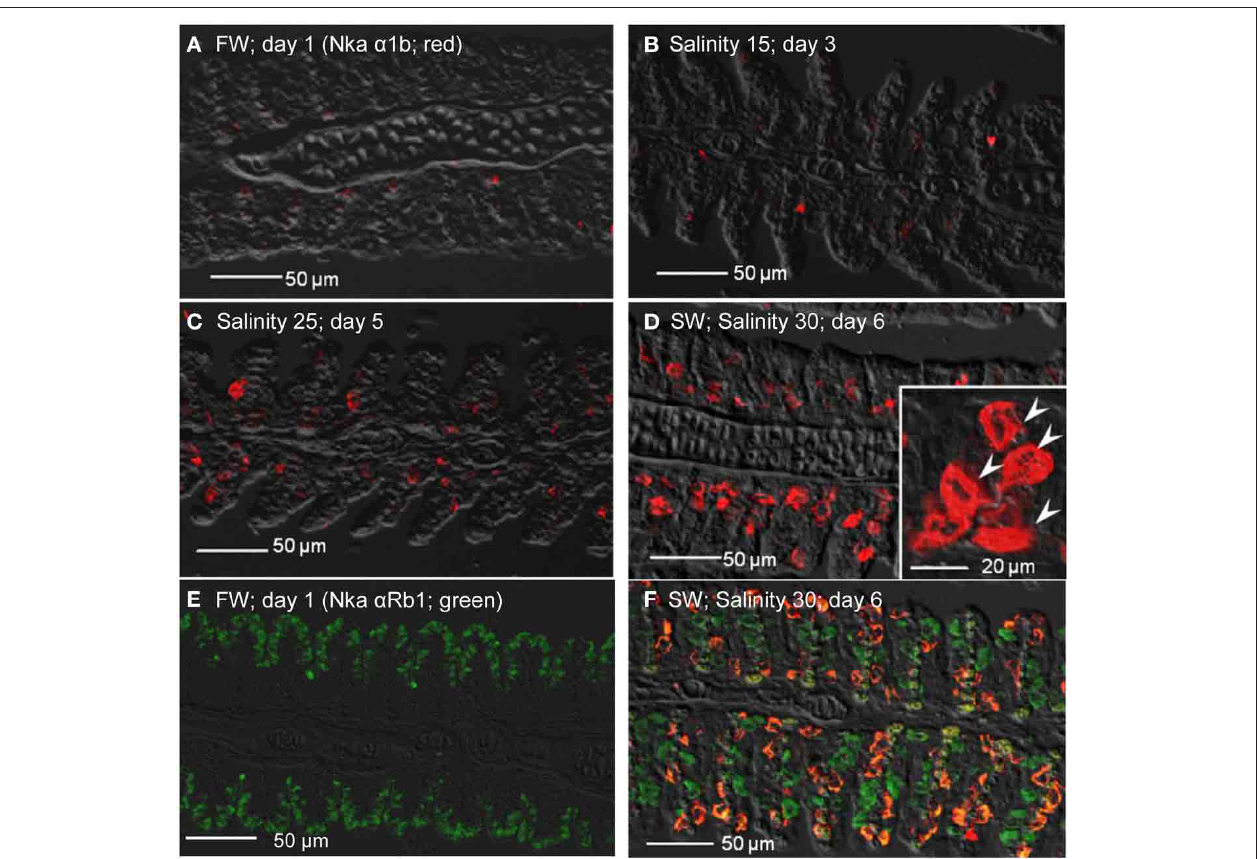
FIGURE 12 | Immunofluorescent localization of Na + /K + -ATPase α 1b (Nka α 1b; seawater isoform; red) in the gills of Anabas testudineus kept in (A) freshwater on day 1 (FW; control), or after 24h of exposure to (B) salinity 15 on day 3, (C) salinity 25 on day 5, or (D) salinity 30 (seawater) on day 6 during a progressive acclimation from freshwater to seawater. Double immunofluorescence staining with anti-Nka α 1b (red) and anti-NKA α Rb1 (green) antibodies was performed on gills of fish kept in (E) freshwater on day 1, or (F) salinity 30 (seawater) on